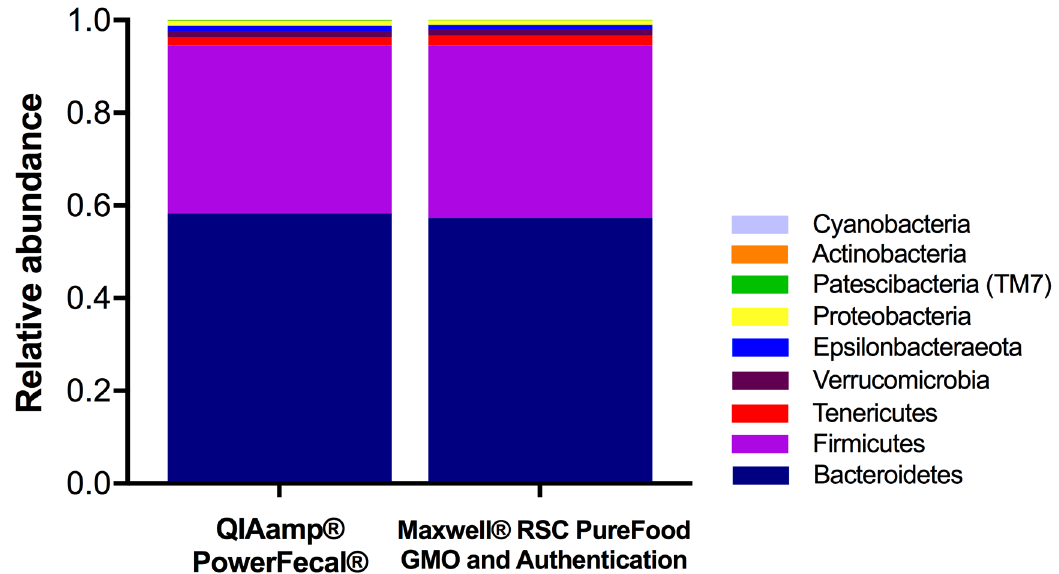
Fig 2. Comparison of DNA extraction methods on next generation sequencing (NGS) relative abundance at the phylum level. NGS using DNA extracted with the QIAamp 1 PowerFecal 1 Kit ( n = 40) and the Maxwell 1 RSC PureFood GMO and Authentication Kit ( n = 39) revealed similar proportions of the 9 most prominent phyla. Relative abundances (mean ± s.d.) are available in S1 Table. https://doi.org/10.1371/journal.pone.0202858.g002 DNA extracted with the Maxwell 1 RSC PureFood GMO and Authentication Kit revealed no significant differences in the number of observed OTUs compared to DNA extractions fol- lowing the QIAamp 1 PowerFecal 1 protocol (34.14 ± 9.15 vs 32.16 ± 9.13, t = 1.08, p (cid:20) 0.29; Fig 4A). To further examine kit-based differences while accounting for abundance of